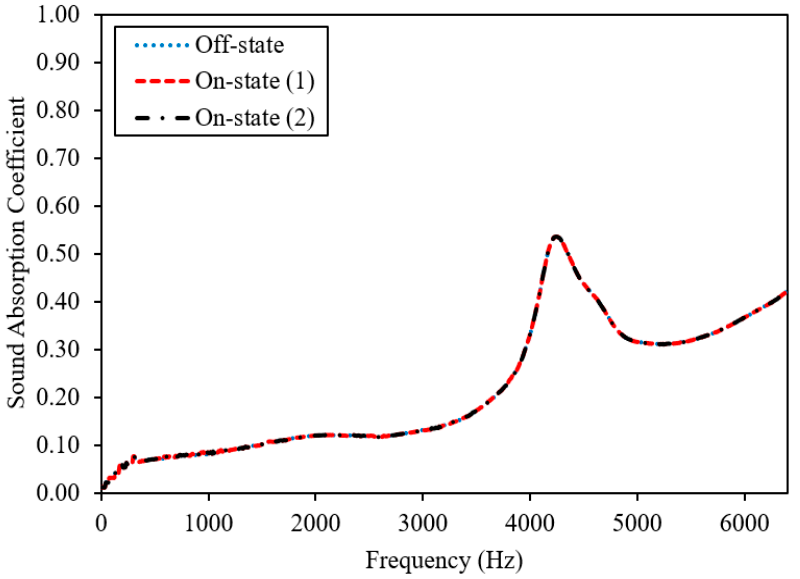
Figure 6. Sound absorption coefficient of virgin foam, 0 wt.% CIPs (Sample A).